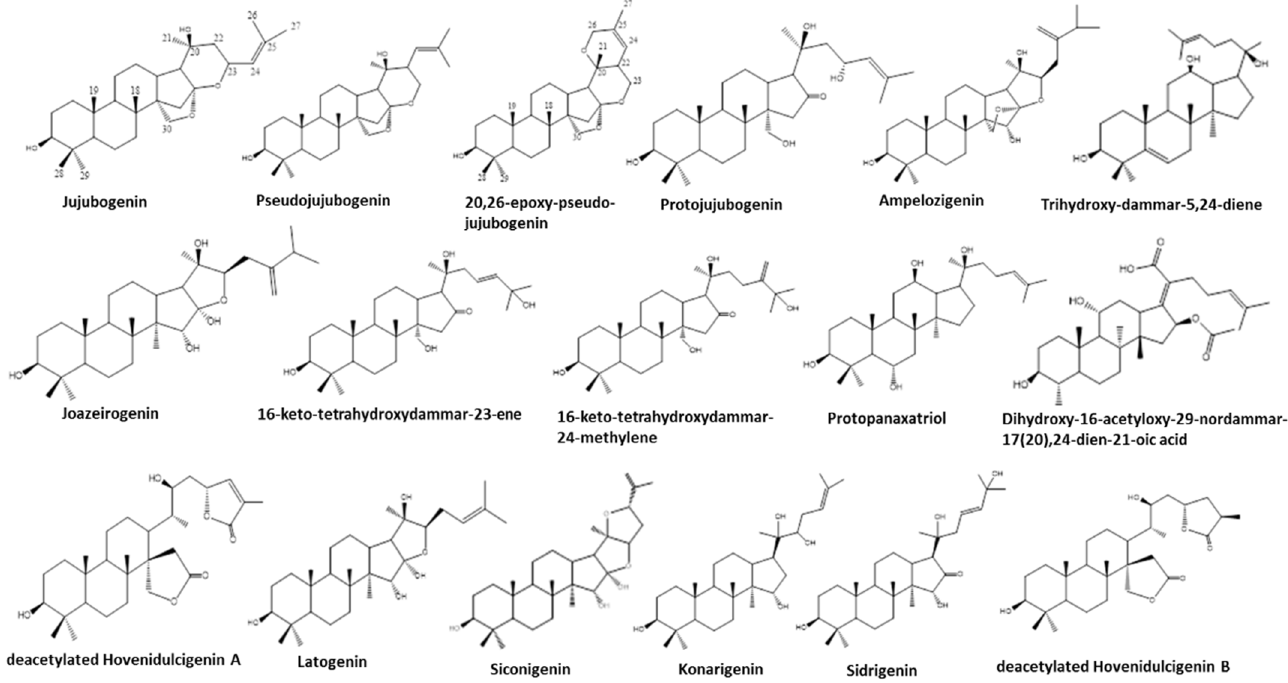
Figure 6. Newly found [66] aglycones of saponins from Ampelozizyphus amazonicus.